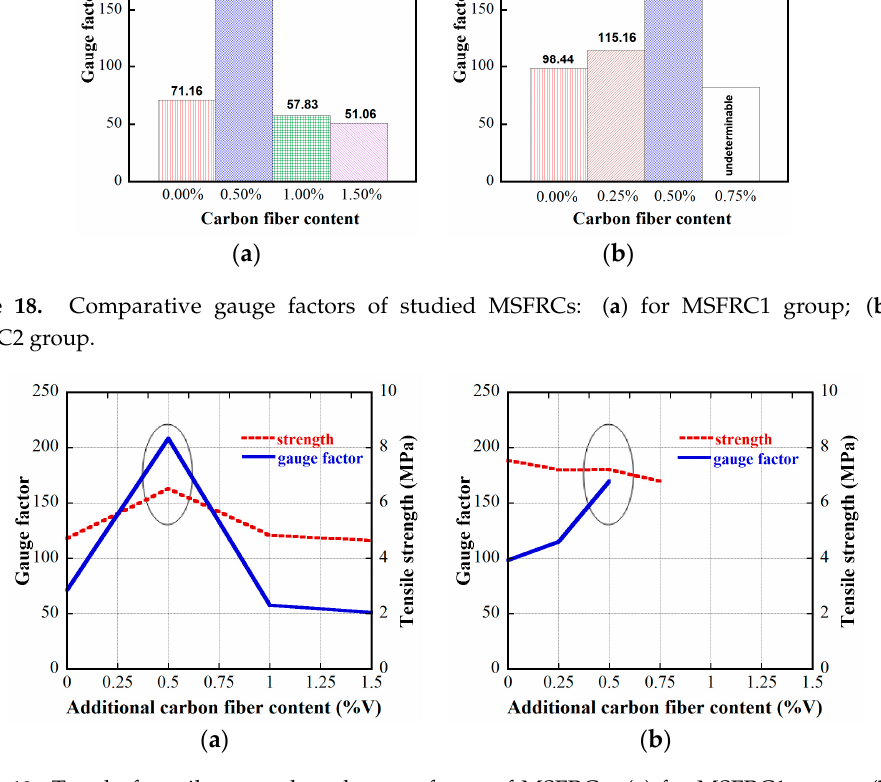
Figure 19. Trend of tensile strength and gauge factor of MSFRCs: ( a ) for MSFRC1 group; ( b ) for